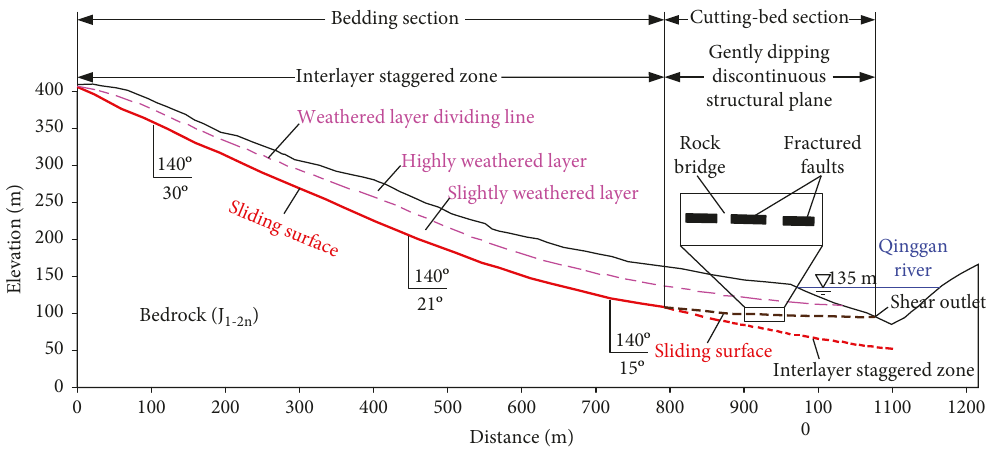
Figure 4: A-A ’ geological pro fi le of the Qianjiangping slope